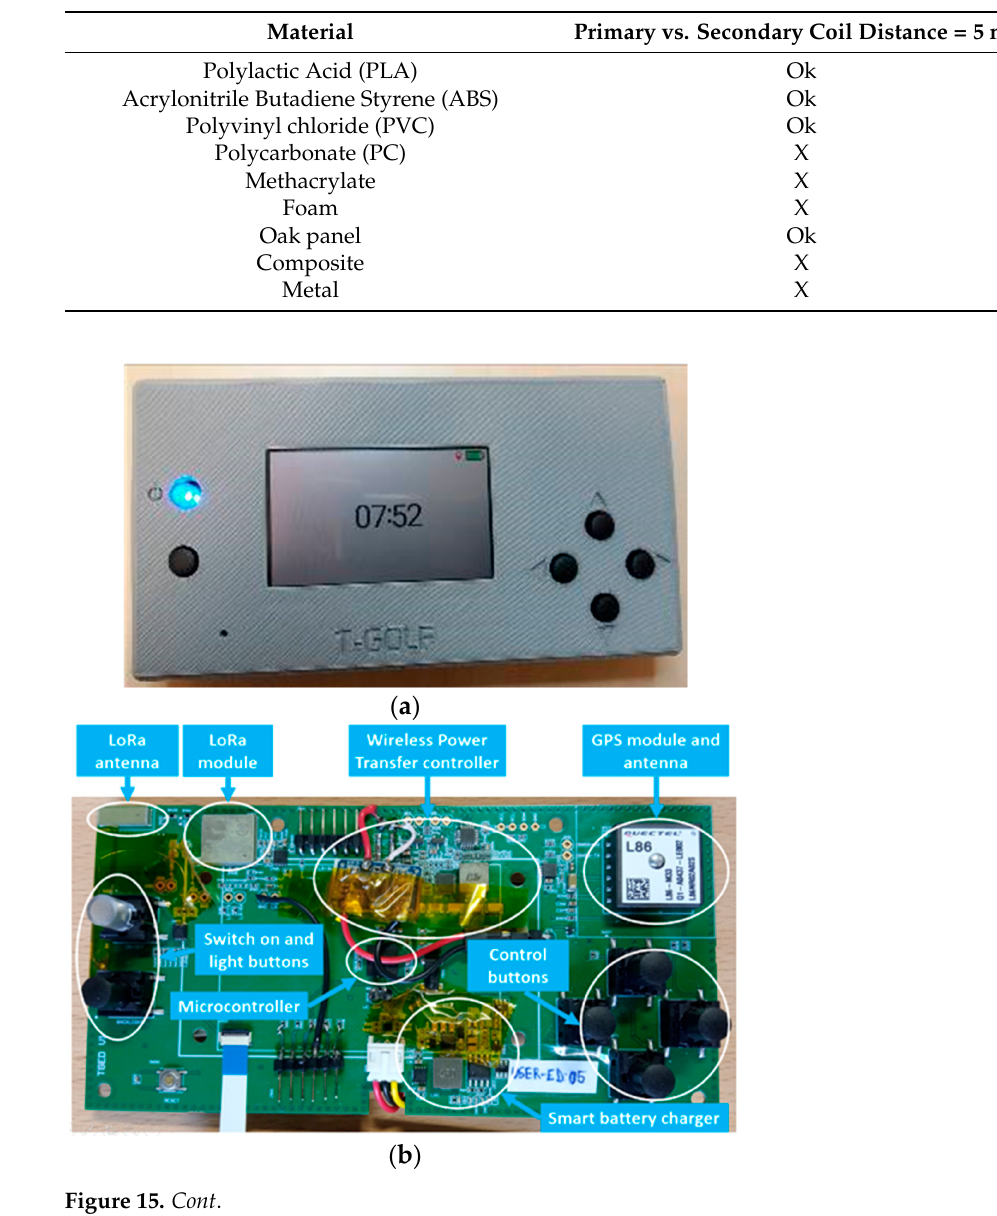
( c ) ( d ) Figure 15. USER-ED prototype: ( a ) view of the encased prototype; ( b ) top view of the electronic board; ( c ) bottom view of the electronic board; ( d ) batteries and encapsulation. 4.2. Software Regarding software programming, two different applications have been imple- mented. The first software application is responsible for the management of the Lo- RaWAN communications (receiving packets, storing them, etc.). This app is based on a